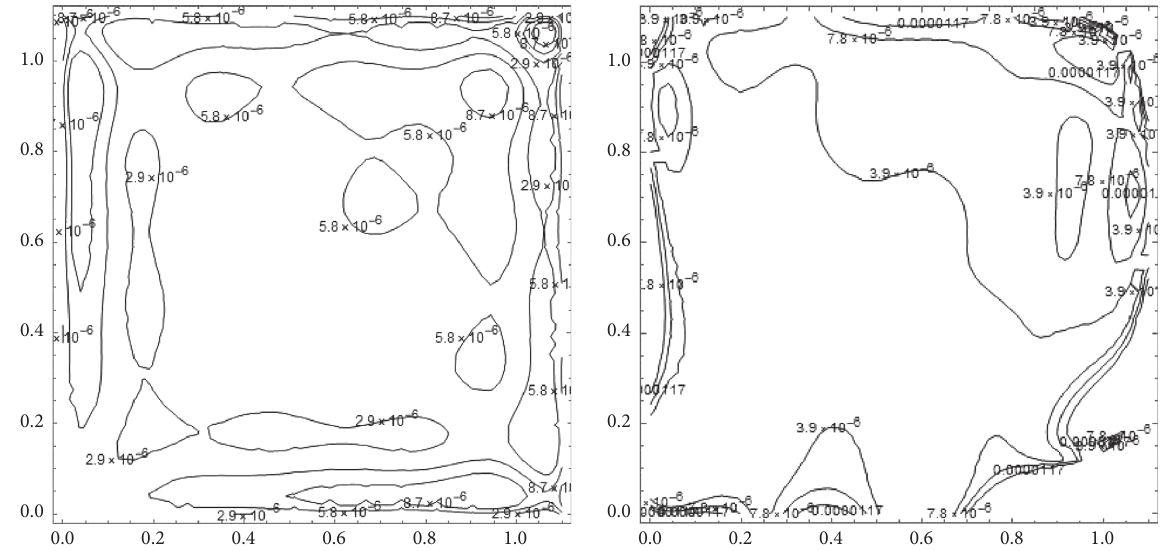
Figure 7: The Contour plot errors in both mesh and meshless cases.